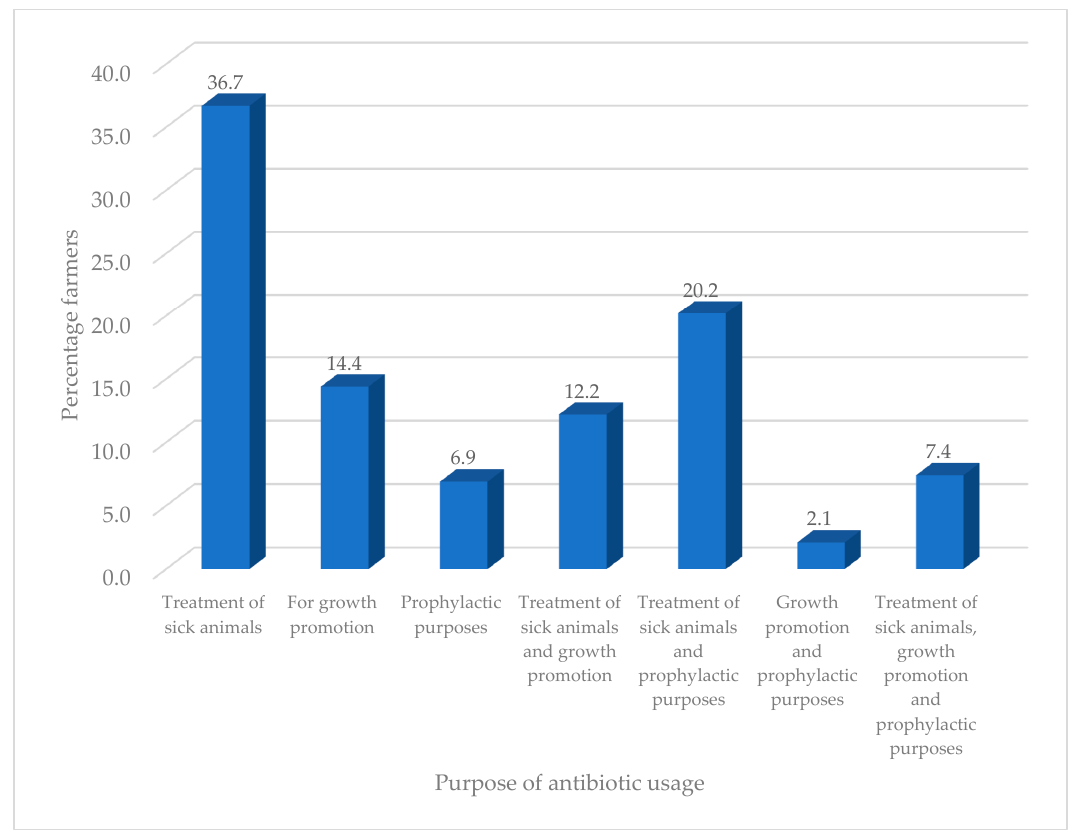
Figure 1. Purpose of antibiotic usage by farmers. Table 2. The knowledge and usage of antibiotics by livestock farmers.